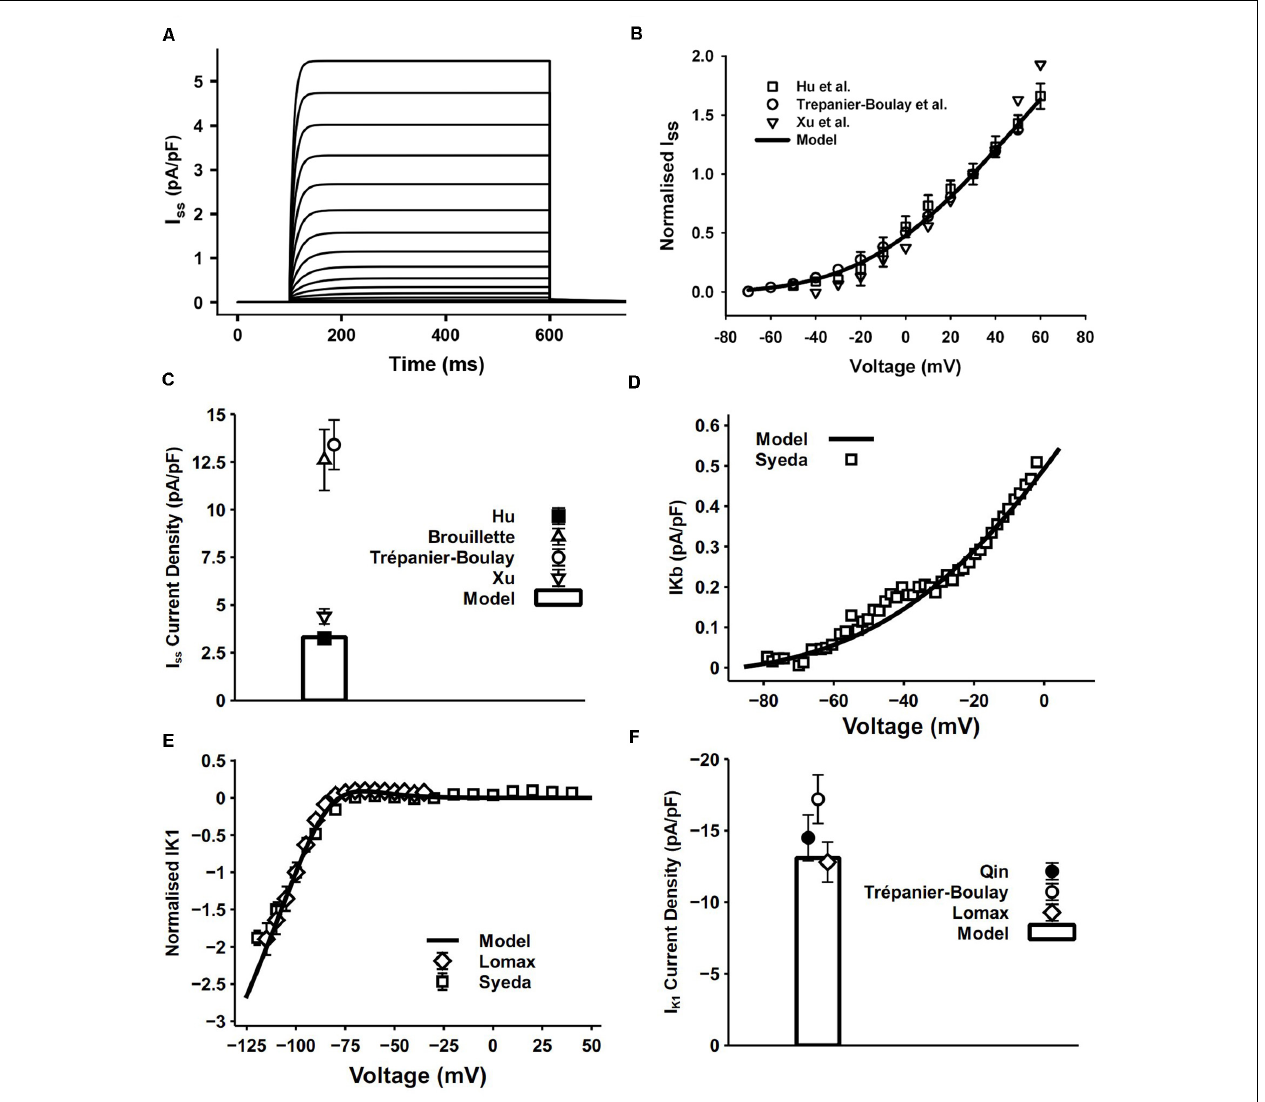
FIGURE 6 | I ss , I Kb and I K1 in the atrial myocyte model and comparison with experimental data. (A) Simulated current traces of I ss . (B) I–V relationship of I ss , values normalized to the current at +30 mV. (C) Current density of I ss at +40 mV (experimental data: Xu et al., 1999c; Brouillette et al., 2004; Hu et al., 2005). (D) I–V relationship of I Kb . (E) I–V relationship for normalized I K1 . (F) Current density of I K1 at –110 mV (experimental data: Lomax et al., 2003a; Trépanier-Boulay et al., 2004; Qin et al.,